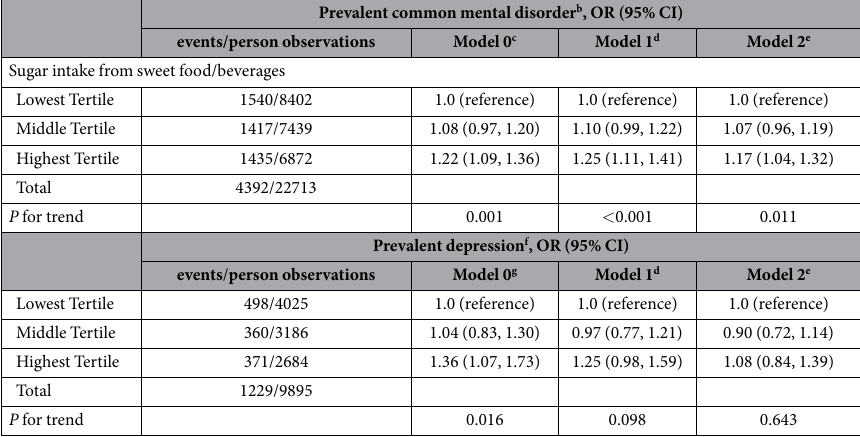
Table 2. Cross-sectional association of sugar intake from sweet food/beverages and prevalent common mental disorder and depression in men and women a . Abbreviations: OR = Odds ratio, CI = Confidence interval, DASH = Dietary Approaches to Stop Hypertension. a Cross-sectional association across phases 3, 5, 7, 9 for common mental disorder and 7, 9 for depression. b Common mental disorder measured using the 30- item General Health Questionnaire.; c CMD model 0 (4675 events/23954 person observations): adjusted for age * sex, ethnicity. d Model 1: additionally adjusted for marital status, last grade level in civil service, smoking, alcohol intake, physical activity, sleep duration. e Model 2: additionally adjusted for energy intake from other foods, modified DASH diet score, fish, coffee and tea intake. f Depression measured using 20-item the Centre of Epidemiologic Studies Depression Scale. g Depression model 0 (1313 events/10269 person observations): adjusted for age * sex,